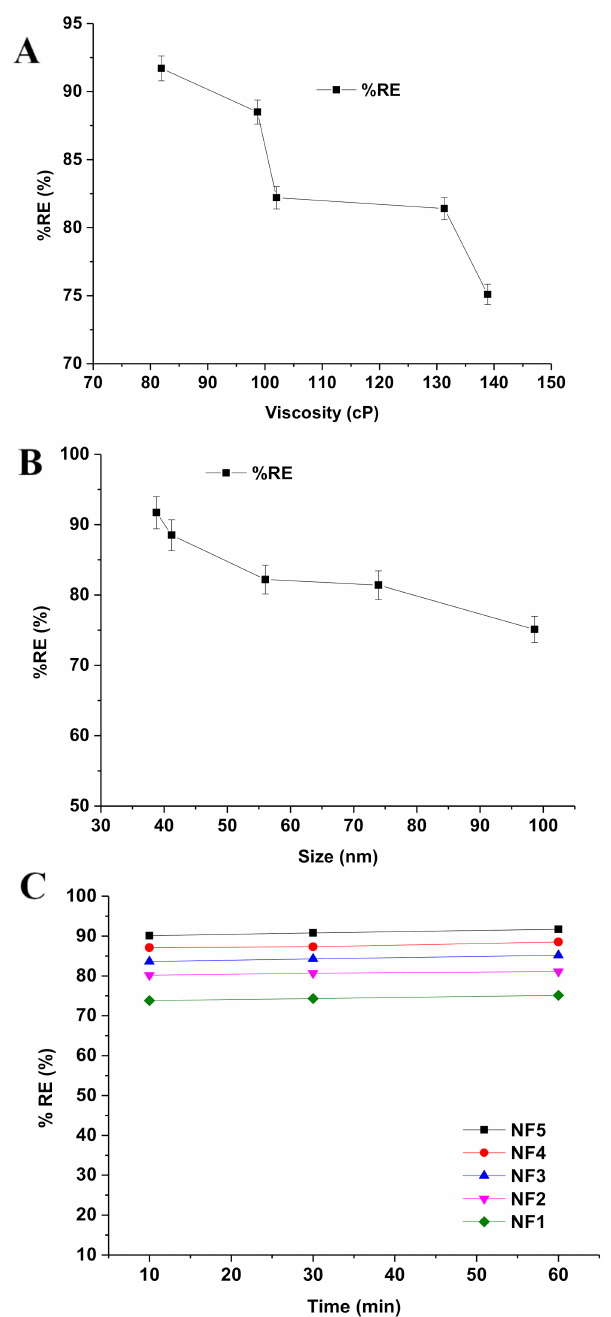
Figure 6. Factors affecting %RE of RIF from an aqueous solution: ( A ) impact of viscosity (cP); ( B ) impact of globule size (nm); and ( C ) impact of exposure time